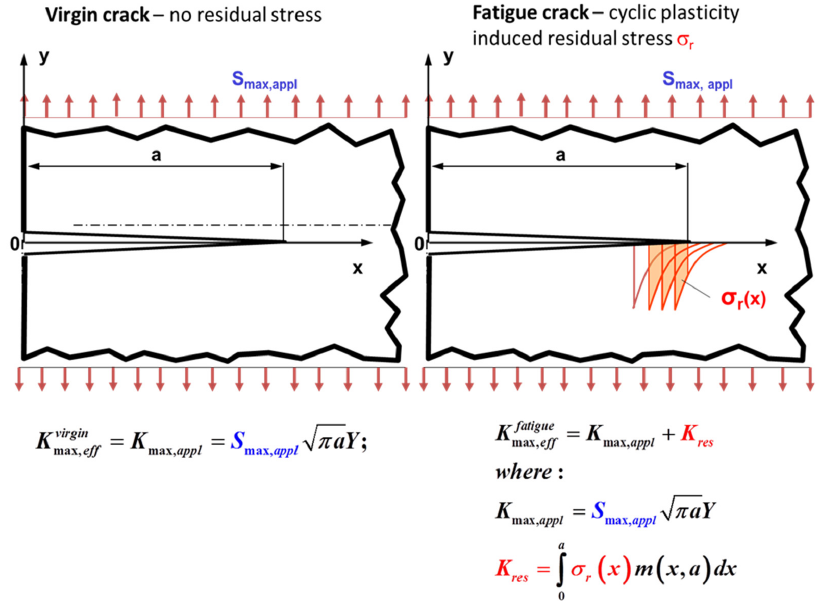
Figure 1. An illustration of plasticity induced residual stresses.